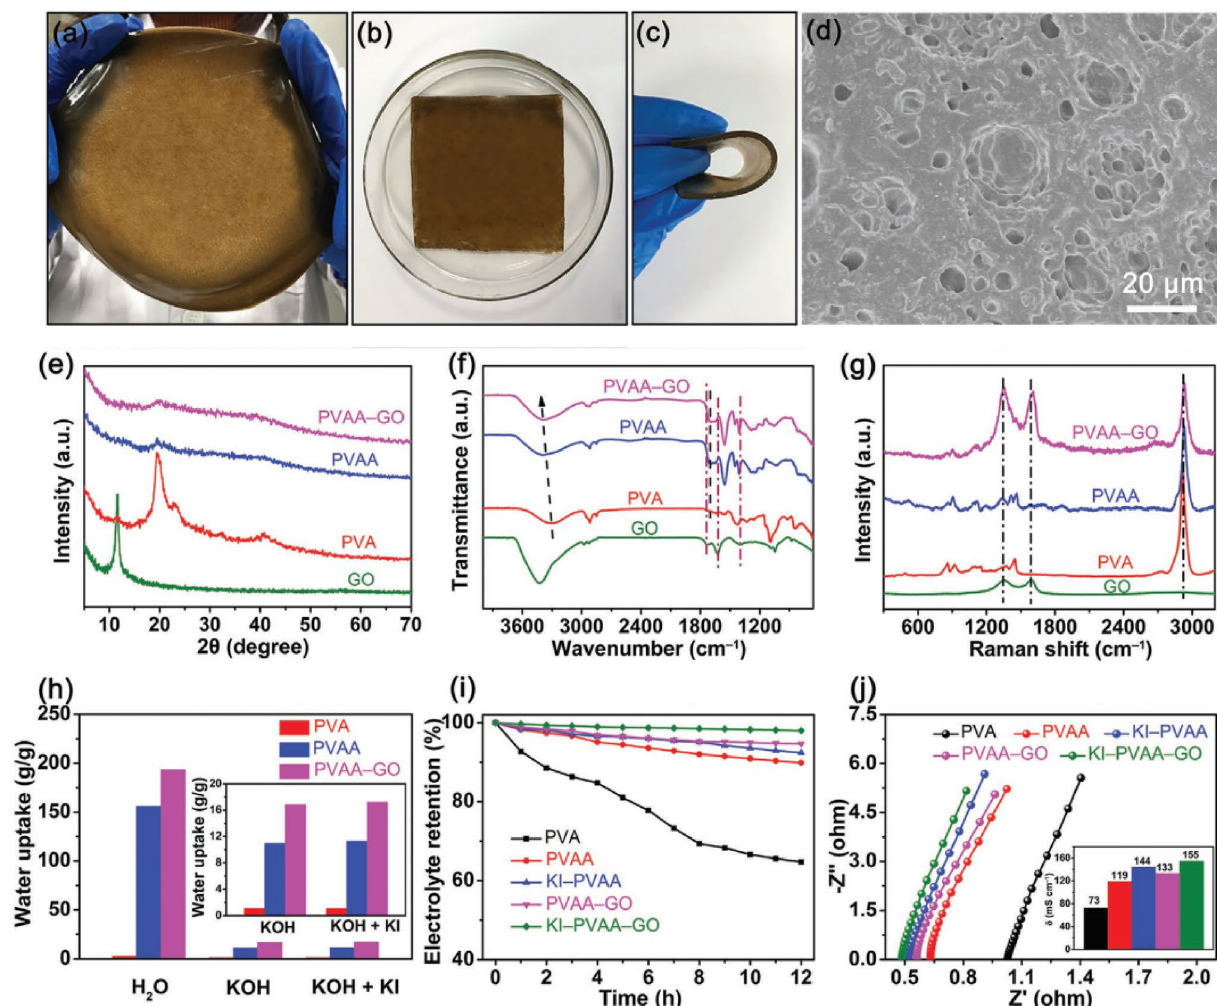
electrolyte and water uptake behaviors of PVA, PVAA-GO and PVAA ( h ), electrolyte retention capabilities of the GPEs ( i ), ionic conduc- tivities of the GPEs ( j ) . Reproduced in permission from ref.